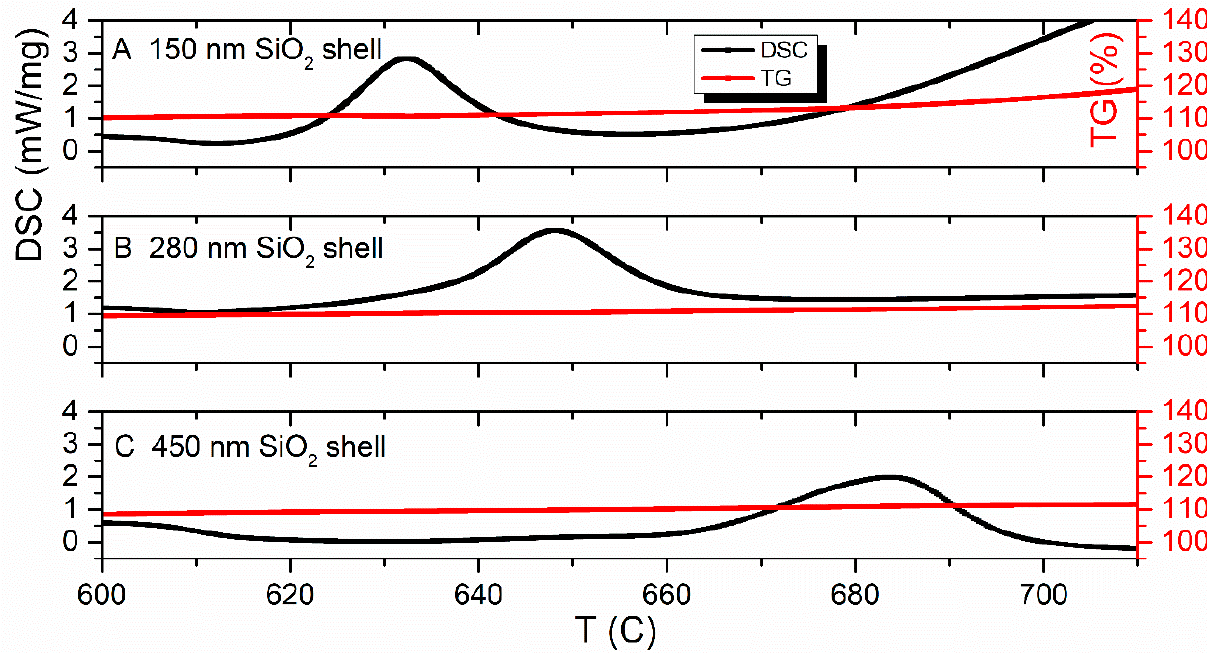
Figure 11. Synchronous thermal analysis results. Detailed 600–720 C temperature interval.